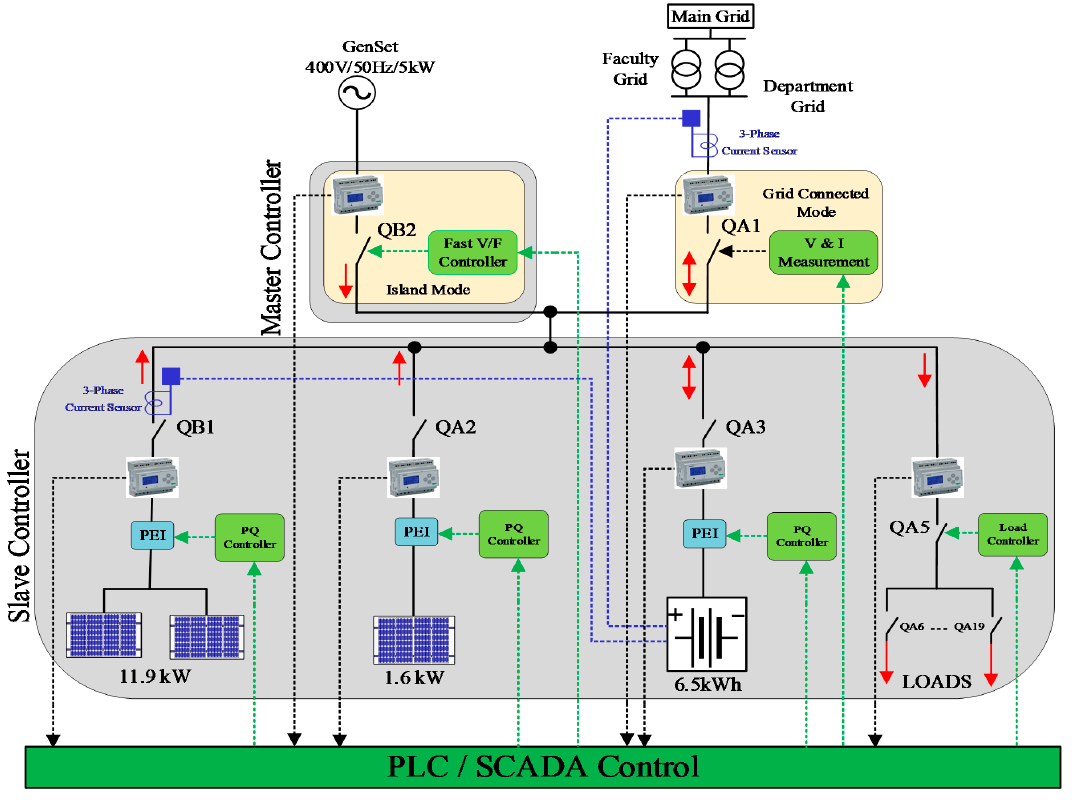
Figure 2. Master–slave control structure in LAMBDA MG. 97